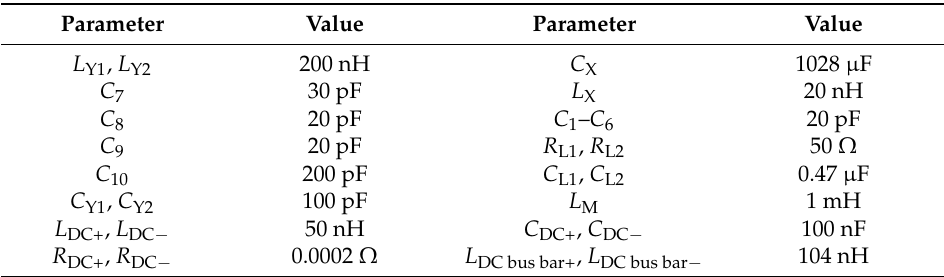
Table 2. Parameters in the motor drive system.